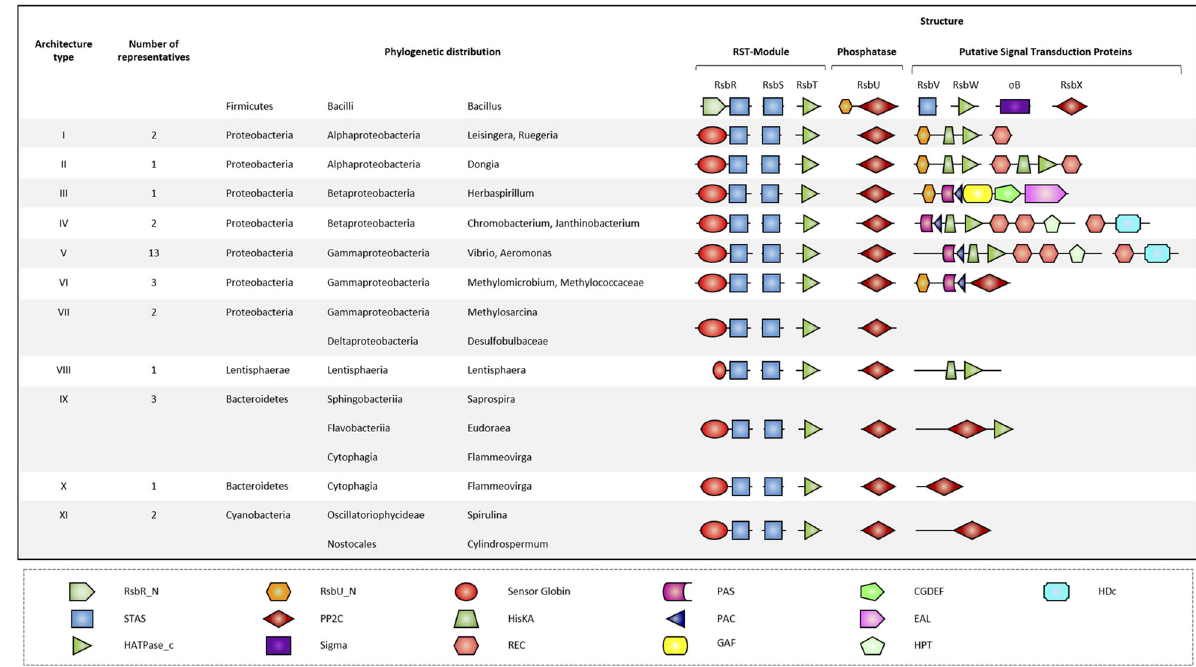
Fig. 3 Phylogenetic distribution of RSTX-modules with a sensor globin coupled RsbR ortholog. The fi rst row shows the domain organization of proteins encoded in the B. subtilis SigB operon. Here, the RST-module is followed by a gene encoding the environmental stress phosphatase RsbU. RsbU is activated upon interaction via its N-terminal domain (RsbU_N) with RsbT. Activated RsbU then conveys the signal to the RsbV-RsbW-SigB partner-switching module. RsbX, the last protein encoded in the operon, functions as a feedback phosphatase, reducing stressosome activity by the dephosphorylation of conserved threonine and serine residues in RsbR and RsbS. In contrast to B. subtilis , in species encoding a sensor globin coupled R-subunit, the putative feedback phosphatase, RsbX, is encoded immediately downstream of the RST-module thus forming a highly conserved RSTX-module. Based on the domain organization, eleven putative downstream architecture types were identi fi ed for these species. Some, but not all, of the downstream-located signaling proteins possess a RsbU_N like domain, supporting the notion that they may indeed function as targets for the RsbT-like protein. Domain abbreviations are as follows: RsbR_N (RsbR non-heme globin N-terminal domain), RsbU_N (RsbU N-terminal domain), PAS (Per- period circadian, Arnt- Ah receptor